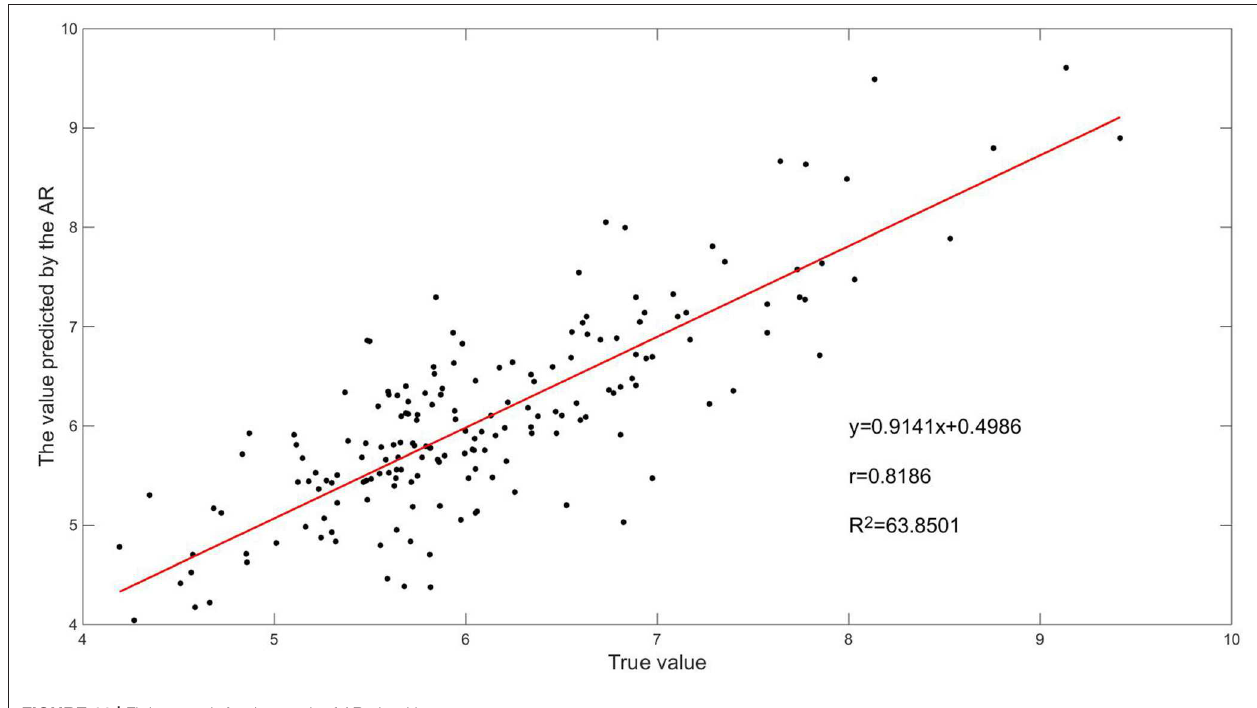
FIGURE 11 | Fitting graph for the result of AR algorithm.